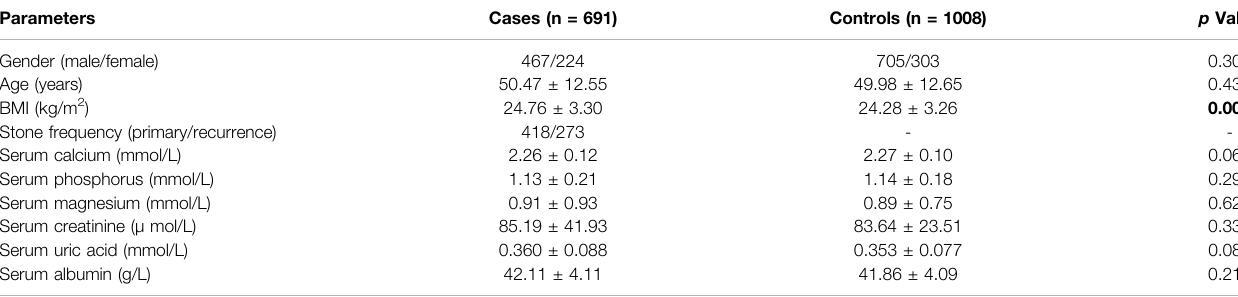
TABLE 1 | Baseline characteristics of the study population. Parameters Cases (n = 691)